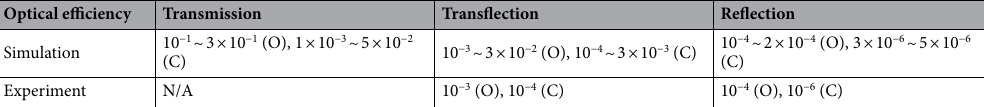
Table 1. Optical efficiency comparison between simulation and experiment for each optical